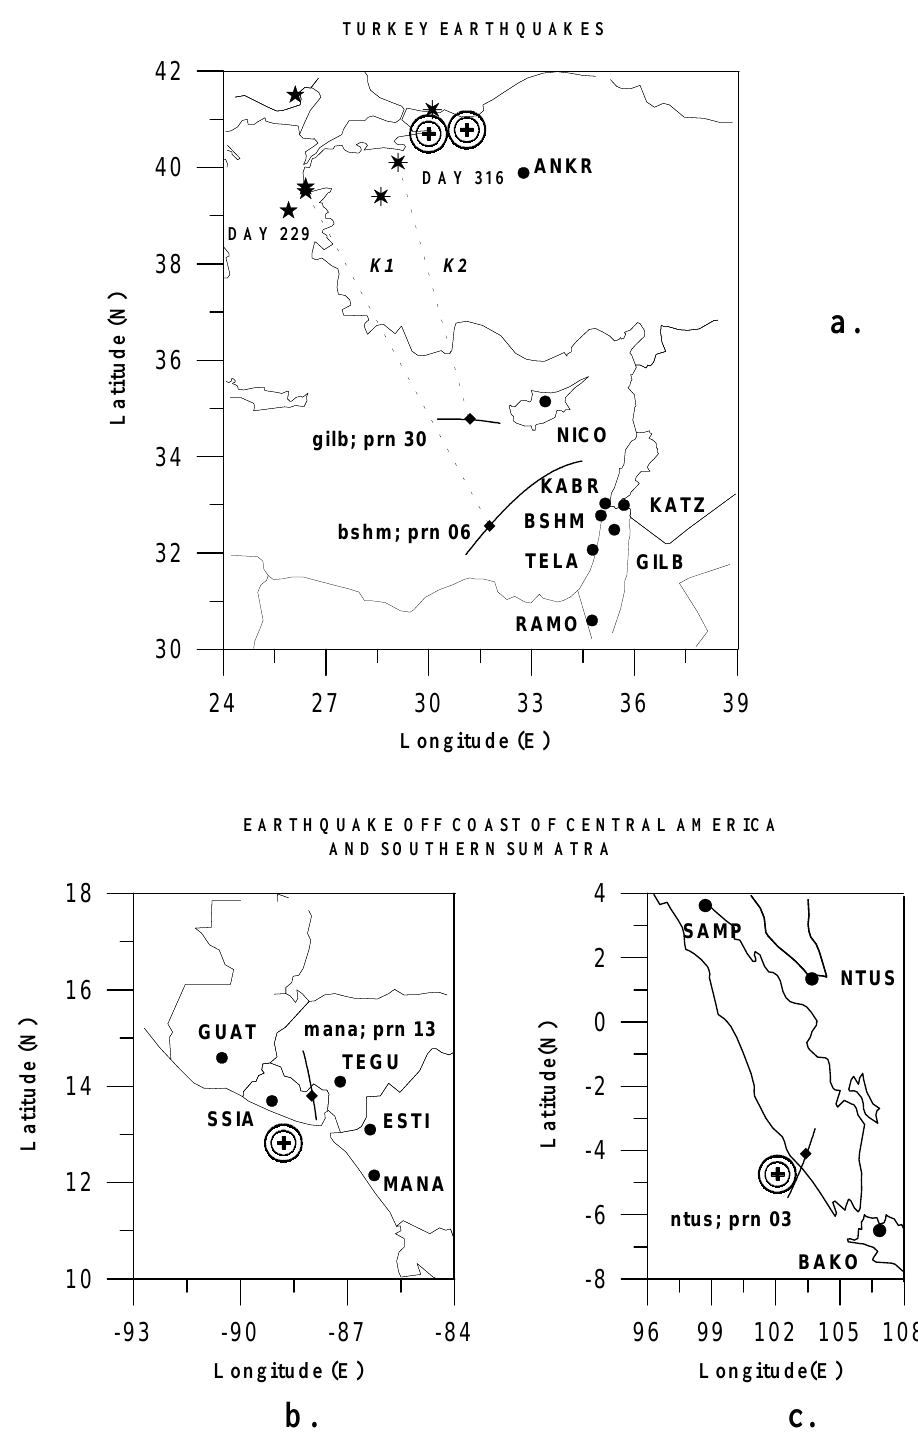
Fig. 1. Experimental geometry during the earthquakes in Turkey – (a) . Crosses show the positions of the earthquake epicenters. Solid curves represent the trajectories of the subionospheric points for each GPS satellite at the height h i = 400 km. Dark diamonds along the trajectories correspond to the coordinates of the subionospheric points at time t p of a maximum deviation of the TEC. Heavy dots and large lettering show the location and the names of the GPS stations, while lower-case letters along the trajectories refer to station names and PRN numbers of the GPS satellites for these trajectories. Asterisks mark the source location at 0 km altitude inferred from the data from the GPS arrays. Numbers at the asterisks correspond to the respective day numbers. Straight dashed lines that connect the expected source and the subionospheric point represent the horizontal projection of the wave vector K t . The scaling of the coordinate axes is chosen from considerations of an approximate equality of the linear dimensions along the latitude and longitude. The same, but for the earthquakes off the coast of Central America on 13 January 2001 – (b) , and in Southern Sumatra on 4 June 2000 – (c)